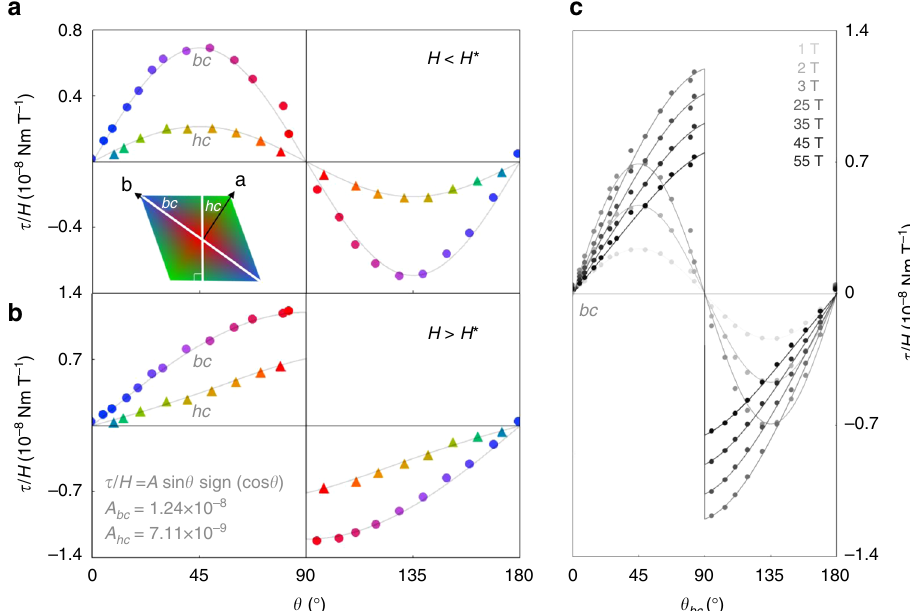
Fig. 3 Evolution of the angle dependence of τ / H with increasing magnetic fi eld at low temperatures. a At 4 K, τ / H evolves from a characteristic sin 2 θ angle dependence at small fi elds to b a correlation-driven sin θ sign(cos θ ) angle dependence at high fi elds. The discontinuity in τ / H across the c -axis ( θ = 90°) implies Ising-like behavior of the magnetization along the crystallographic b -direction. c The angle dependence of τ / H in the bc -plane at discrete fi eld values shows a clear deviation from sin 2 θ behavior that persists up to 55